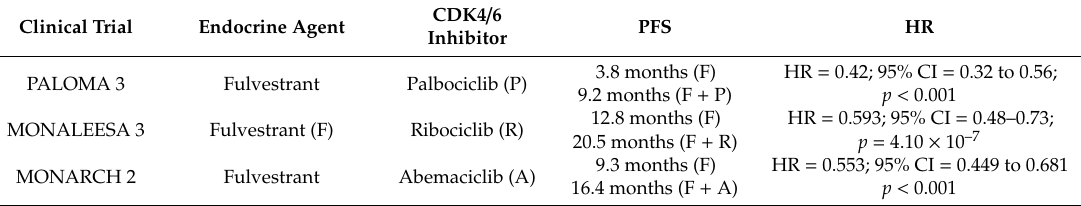
Table 2. CDK4 / 6 inhibitors in the second-line